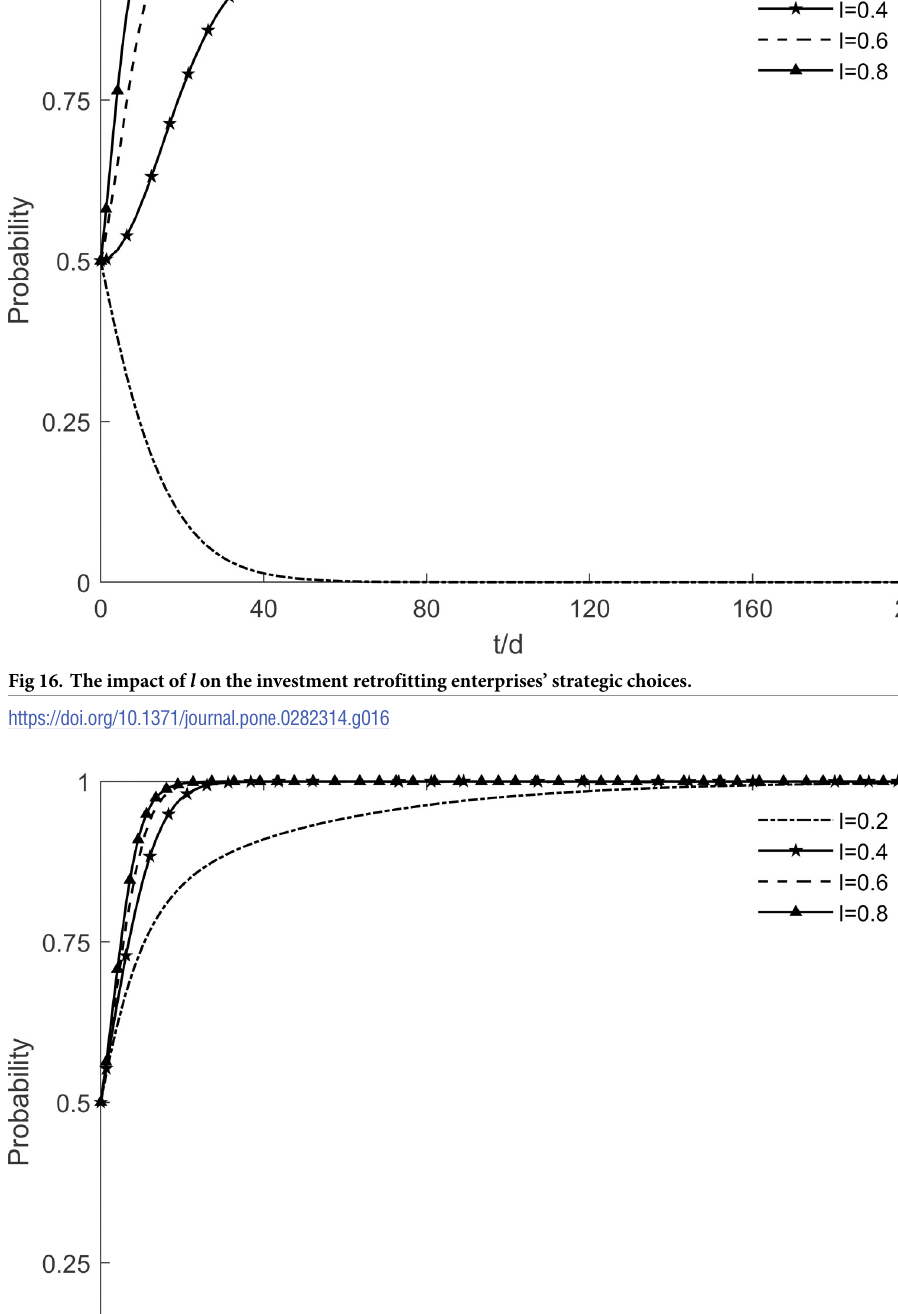
PLOS ONE | https://doi.org/10.1371/journal.pone.0282314 March 16,